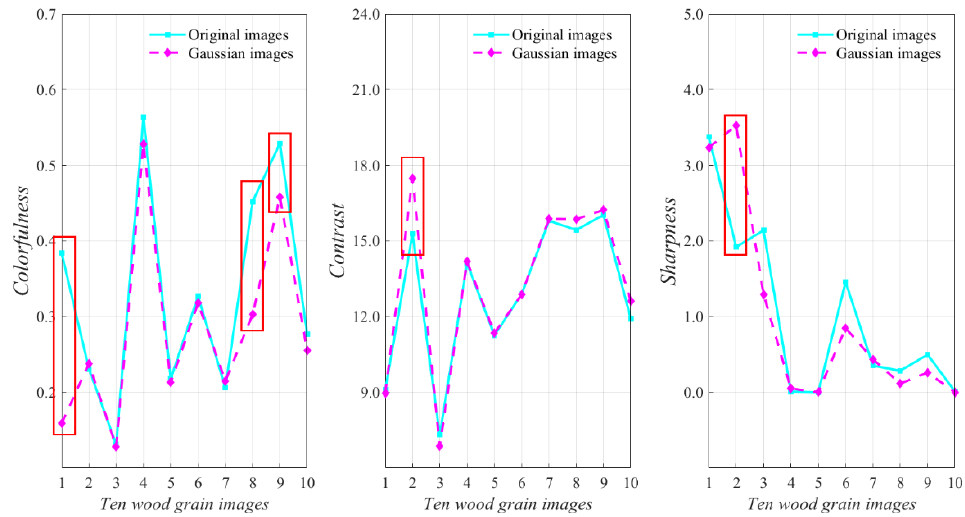
Figure 3. Changing trends of objective evaluation values of colorfulness, contrast, and sharpness on the ten images before and after the Gaussian histogram specification.